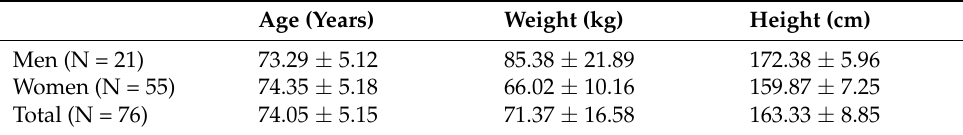
Table 1. Demographic characteristics for the sample (N =